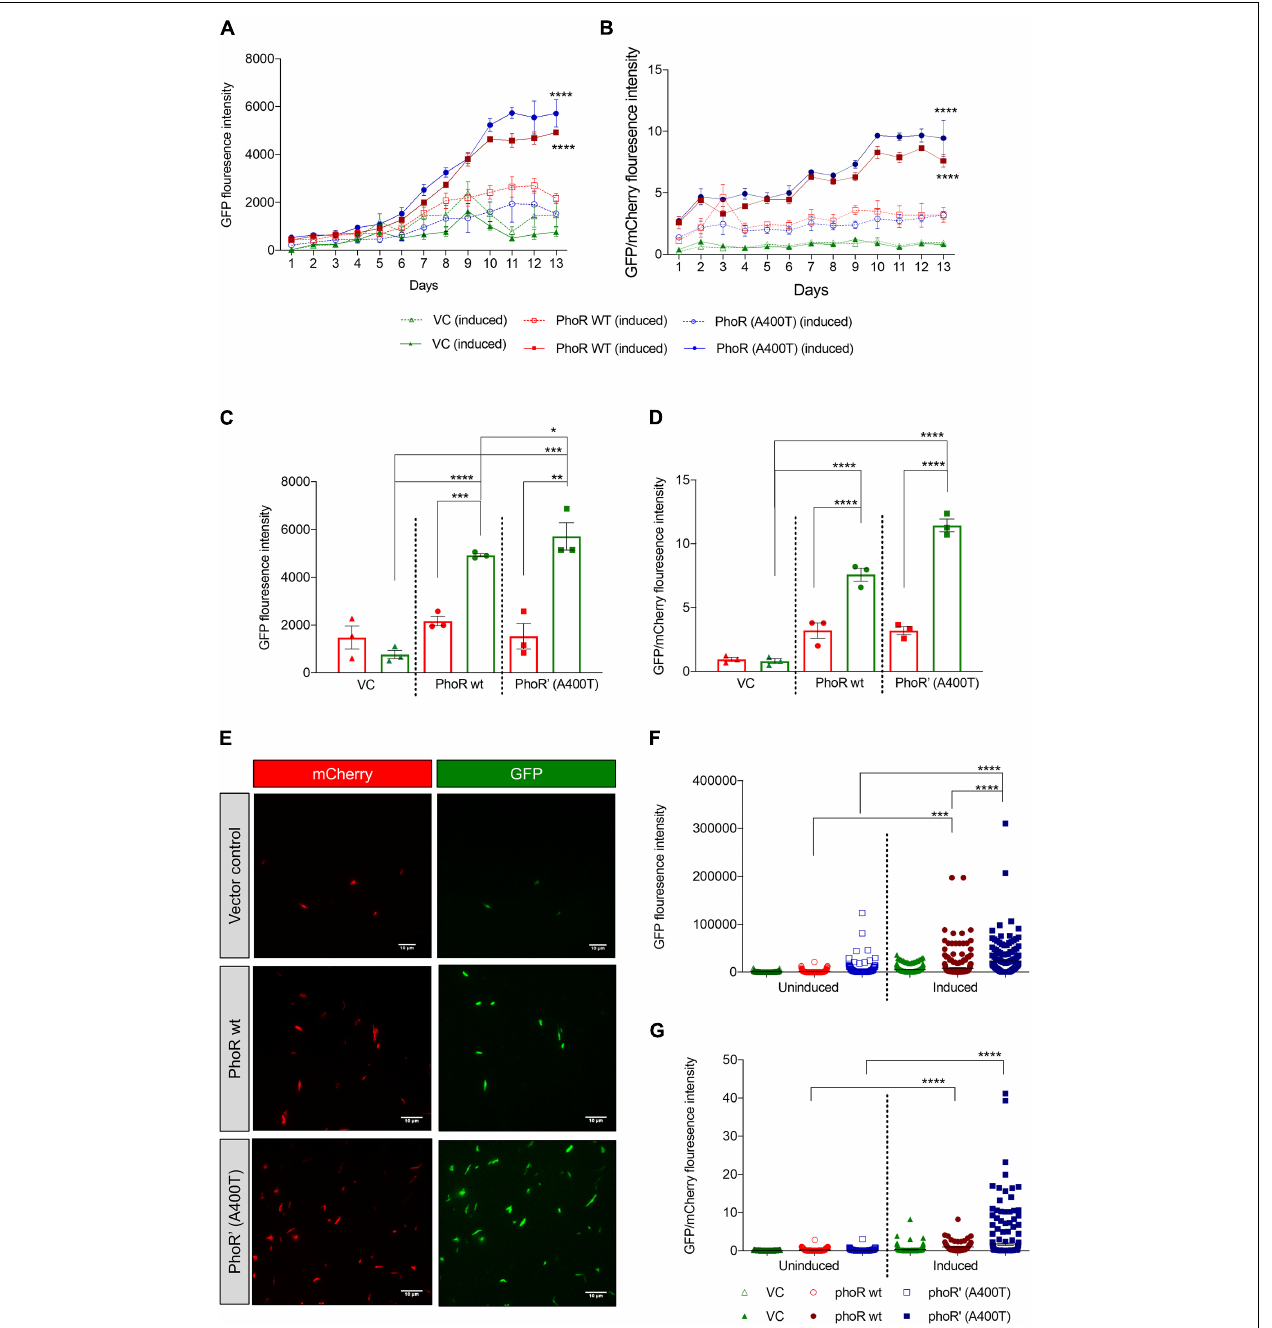
FIGURE 5 | Expression analysis of PhoPR regulated aprA gene using promoter-reporter system in Mycobacterium tuberculosis H37Ra. (A) Green fluorescent protein (GFP) fluorescence in H37Ra strains carrying aprA promoter-reporter plasmid and integrative vector pCV125 alone or containing wild-type or mutant phoPR operon in cultures grown at pH 7.2 or at pH 5.5. The solid lines show GFP fluorescence at pH 5.5, and the dotted lines that at pH 7.2 over 13 days. (B) Analysis of the relative fluorescence ratio of GFP/mCherry, at pH 5.5, solid lines; and at pH 7.2, dotted lines (triangles, vector control; circles, phoR wt; and squares, phoR ’ (A400T) mutant). (C) Quantitation of GFP fluorescence in cultures (as indicated) at day 12 at pH 5.5 (green, induced) and at pH 7.2 (red, uninduced). (D) Quantitation of the relative fluorescence ratio of GFP/mCherry from induced and uninduced cultures at day 12 at pH 5.5 (green) and at pH 7.2 (red). (E) Fluorescence microscopy images showing GFP expression in cultures at day 12 in indicated strains. Left panel, mCherry; right panel, GFP. (F) Quantitation of GFP fluorescence and (G) relative fluorescence by GFP/mCherry ratios by fluorescence microscopy in various strains and conditions (as indicated) from ∼ 300 individual bacilli. n = 3, where n represents the number of biological replicates used in the experiments. p -values * ≤ 0.05, ** ≤ 0.01, *** ≤ 0.001, and **** ≤ 0.0001, were determined by two-way ANOVA.